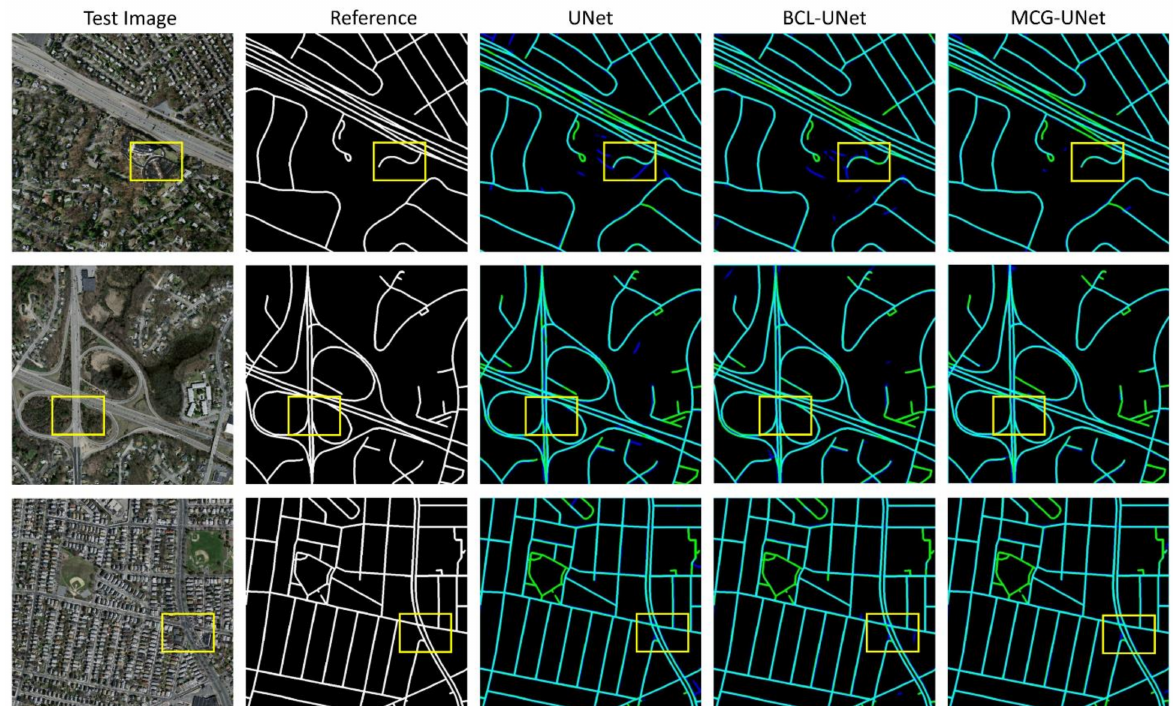
Figure 8. Obtained products with the presented UNet, BCL-UNet, and MCG-UNet networks from the Massachusetts road dataset. The yellow, blue, and white colors present the FNs, FPs, and TPs, respectively.